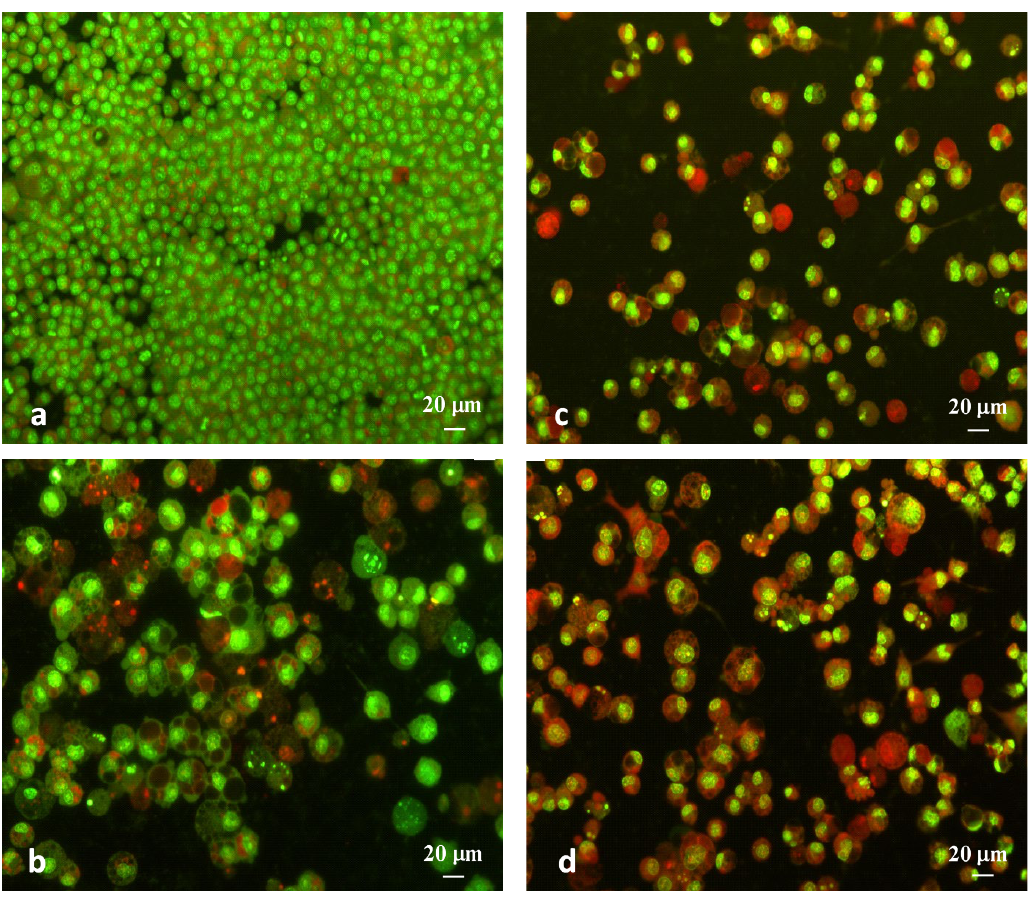
O, c) complex 1 ; d) complex 2 2